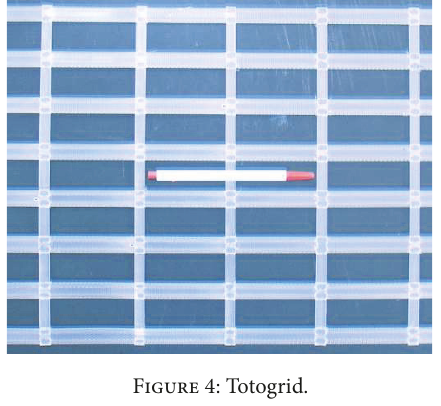
Figure 4: Totogrid.